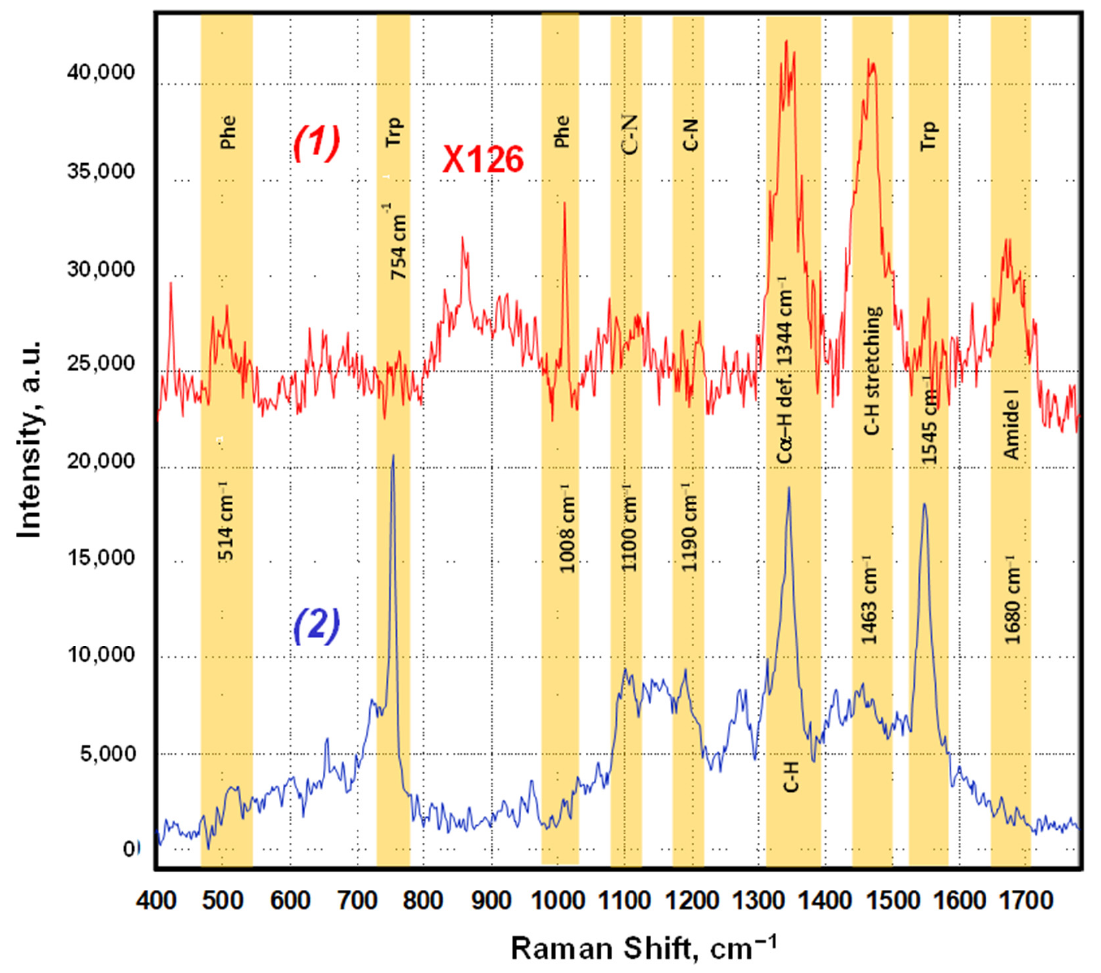
Figure 7. SERS spectral features of the SARS-Cov-2 RBD with reduced disulfide bonds. (1) An unenhanced Raman spectrum obtained from the native SARS-Cov-2 RBD from a dried drop on a glass slide, about 1.3 pg of RBD. The scaling factor for the integrated intensity is 126. (2) A SERS spectrum obtained from about 1 fg of the sample of SARS-Cov-2 RBD with reactive thiol groups (reduced disulfide bonds) on the silver surface of the SERS-active substrate demonstrating the dominance of the Trp amino-acid residue signals.